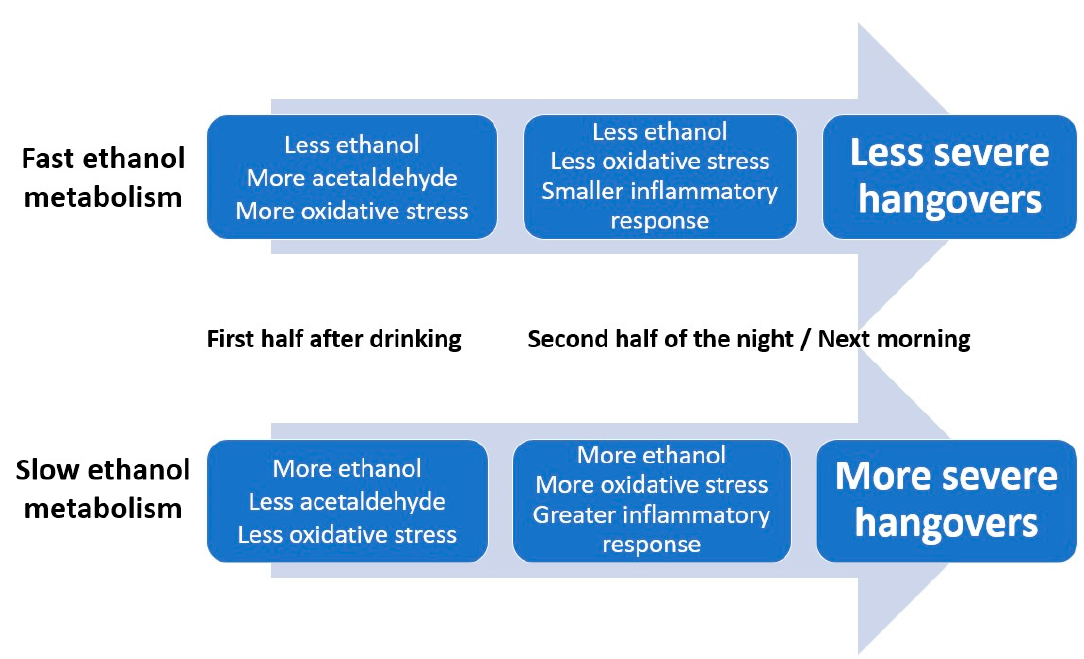
Figure 4. The relationship of alcohol metabolism, oxidative stress and the inflammatory response with hangover severity. Note: The rate of alcohol metabolism, i.e., the conversion of ethanol into acetaldehyde and other aldehydes, seems to be the primary determinant of hangover severity.